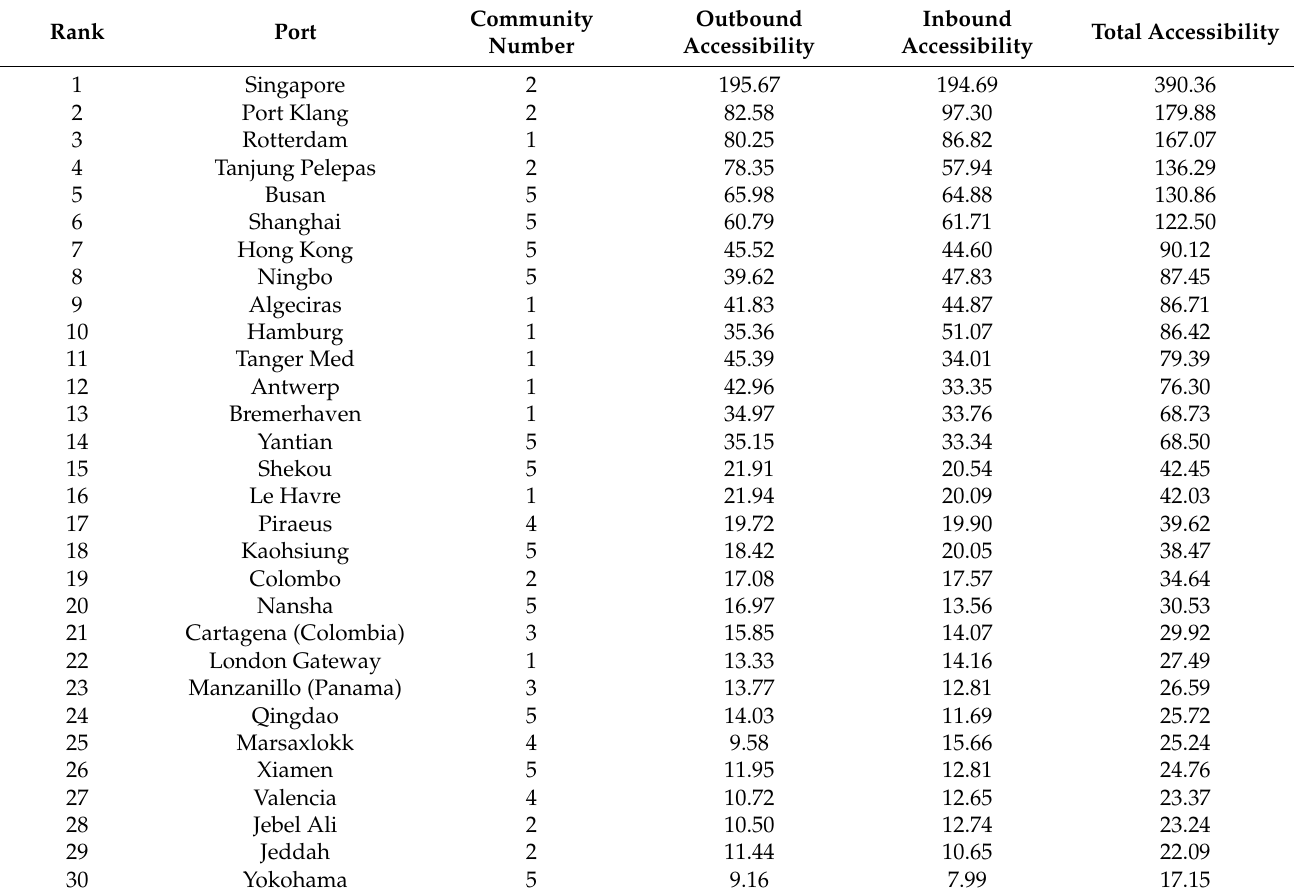
Table 7. Top 30 ports with the highest total accessibility and their community